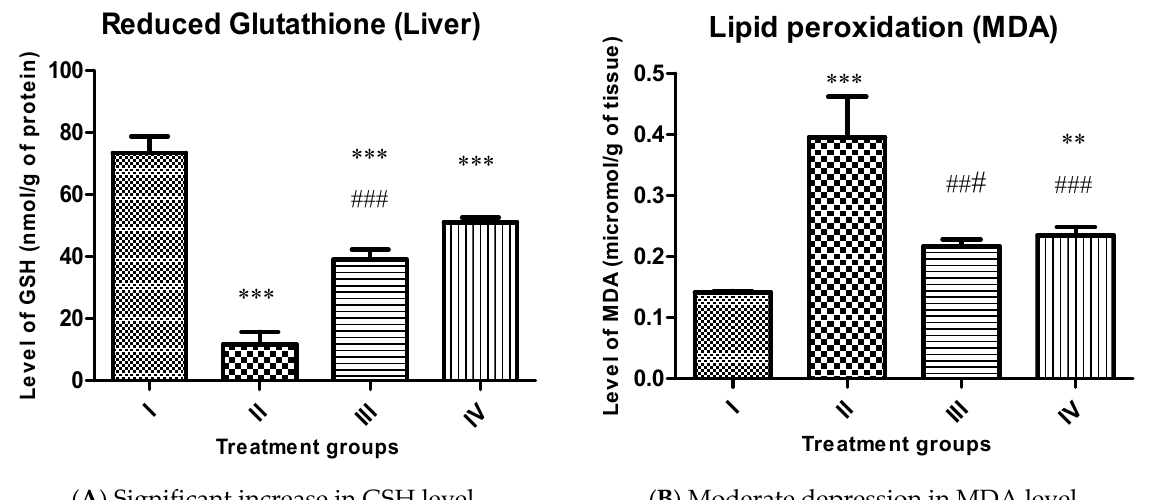
Figure 8. Showing bars of oxidative stress markers (GSH Urea ( A ) and MDA Urea ( B ) levels) of the indicated groups. All the data has been expressed in mean ± SEM for each group. * indicates statistically different from the control (group I) at p ≤ 0.05 while # indicates statistically different control positive (group II). Also ** and ## indicate p ≤ 0.005 while *** and ### indicate p ≤ 0.001.